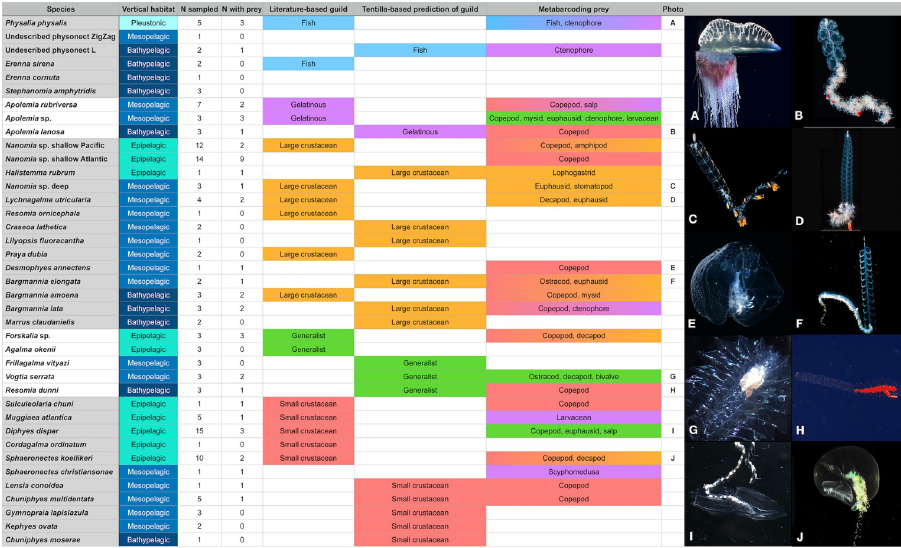
Fig 2. Summary table of the siphonophore species sampled for this study indicating their vertical habitat, the number of specimens sampled, the number of specimens with recognizable prey sequences, and hypothesized feeding guild. Guilds are based on published feeding records used in Damian-Serrano et al. [26], predicted feeding guild from the DAPC analysis in Damian-Serrano et al. [27] based on tentilla morphology, and prey found in this study. Photo credits: (A) Casey Dunn, (B, D,) Stephan Siebert, CC BY licensed and reprinted from Munro et al. [73], (C) reprinted from https://www.theredshrimp.com/ with permission from Reyn Yoshioka, original copyright